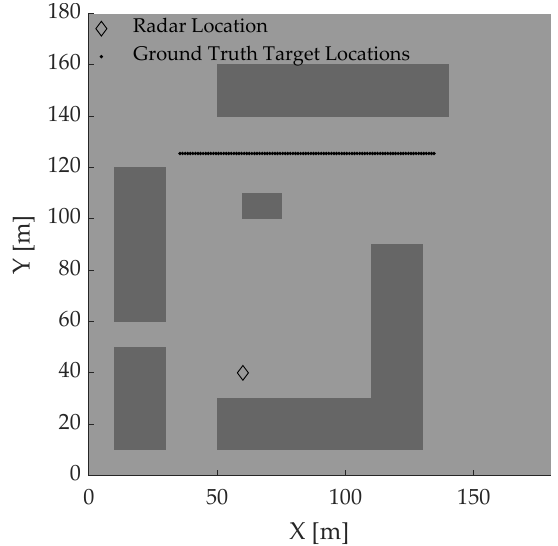
Figure 4. Simulation scenario